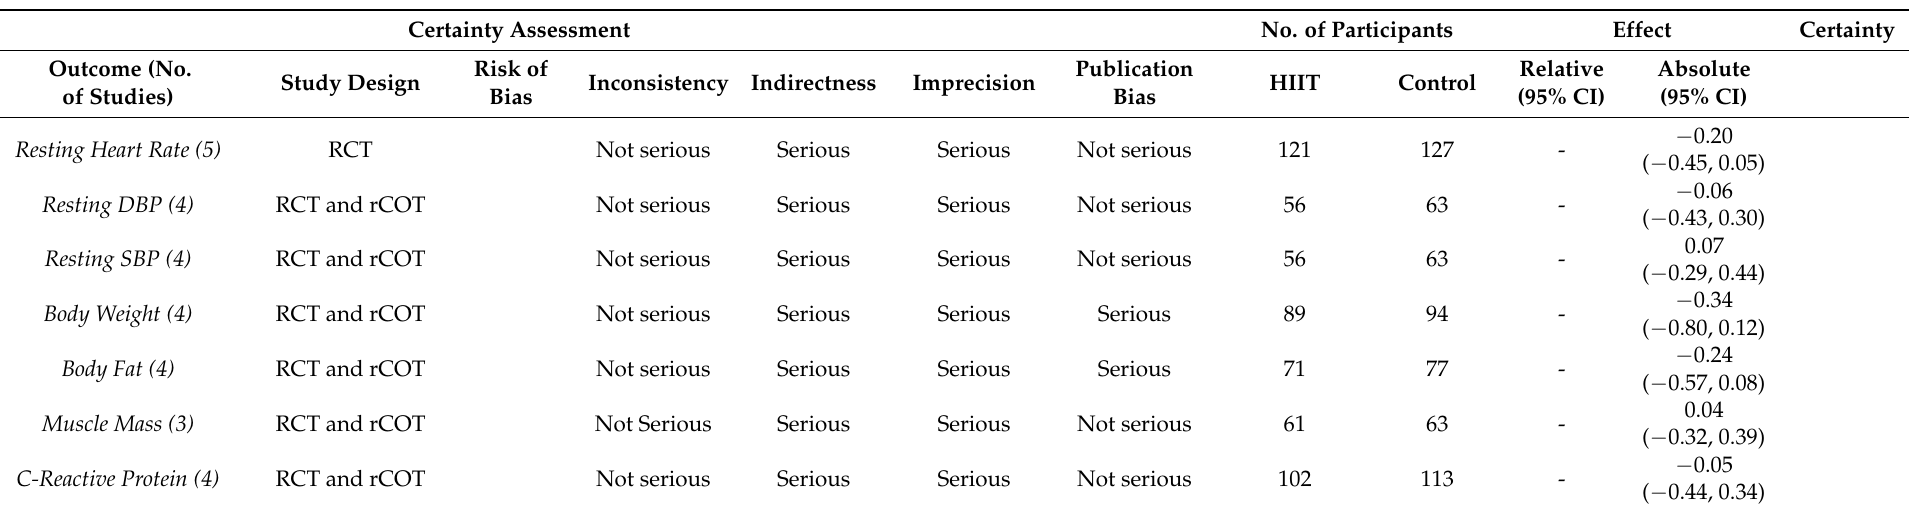
Table A4. Summary of findings and quality of evidence